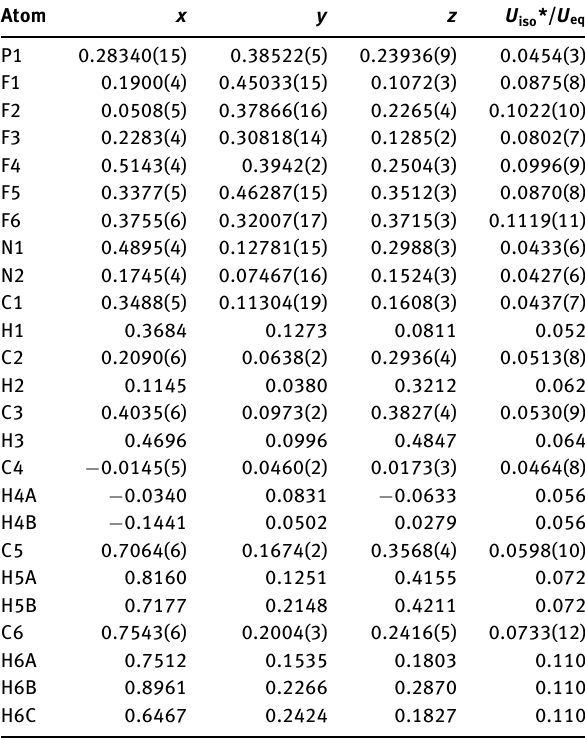
Table 2: Fractional atomic coordinates and isotropic or equivalent isotropic displacement parameters (Å 2